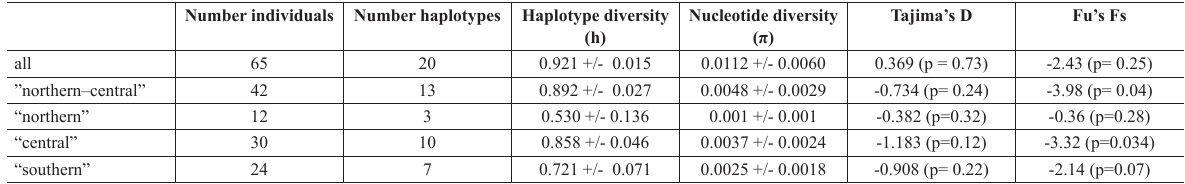
Table 2. Genetic indices. Standard genetic indices are reported for the whole species as well as for each of the groups.